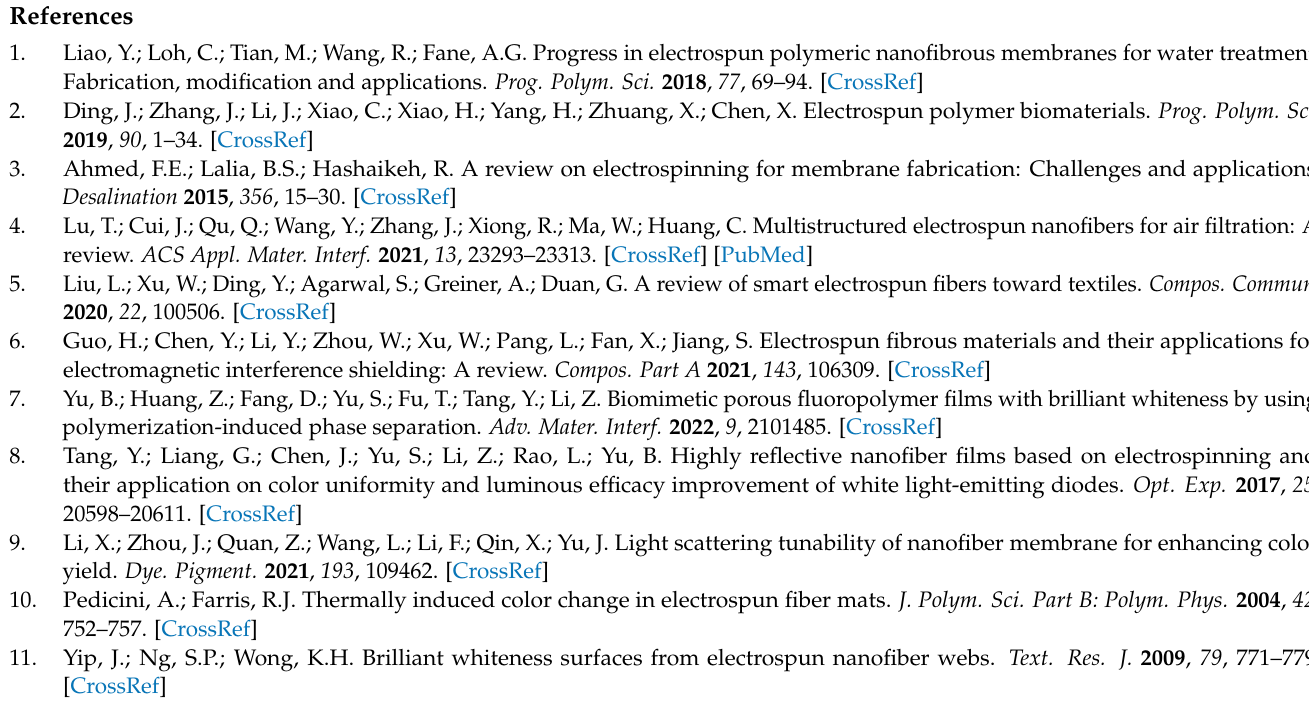
Figure S3: SEM images of the FPI UFMs together with the average fiber diameters ( d av ). ( a ) FPI-1, ( b ) FPI-2, ( c ) FPI-3, ( d ) FPI-4, ( e ) FPI-5; Figure S4: Water contact angles of FPI UFMs. ( a ) FPI-1, ( b ) FPI-2, ( c ) FPI-3, ( d ) FPI-4, ( e )